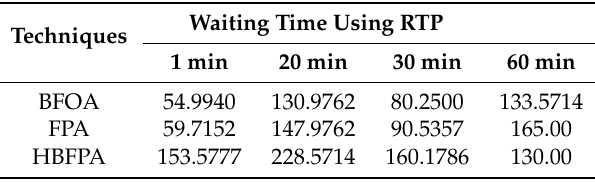
Table 10. Waiting time for 24 h (for single